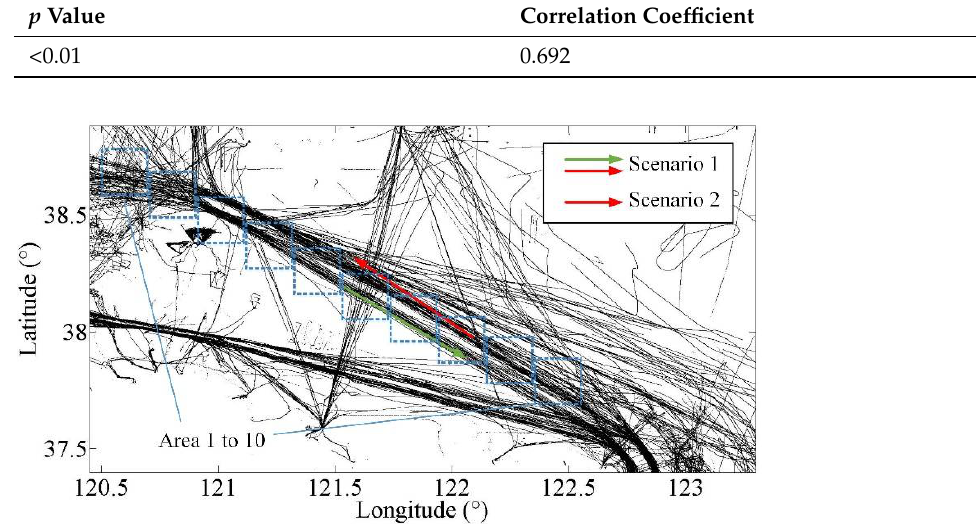
Figure 12. The locations of these ten water